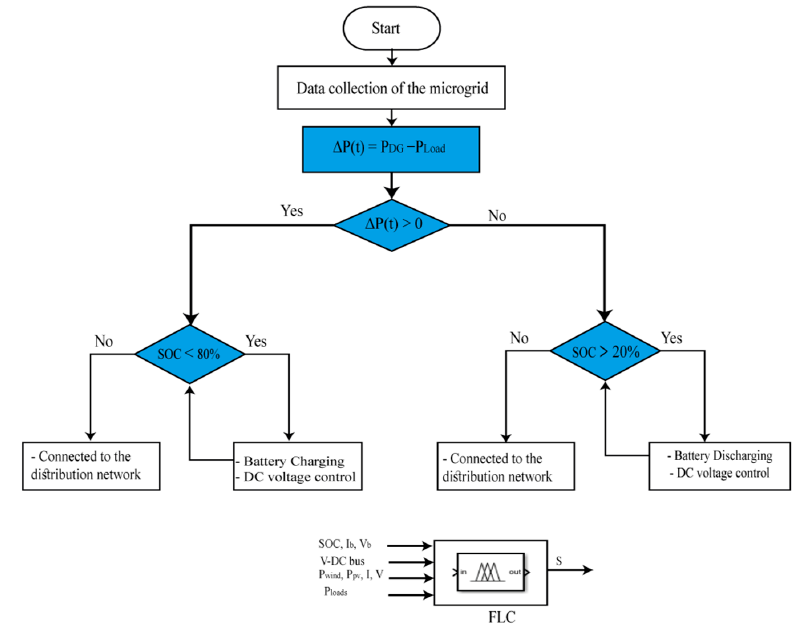
Figure 9. Proposed energy management algorithm.